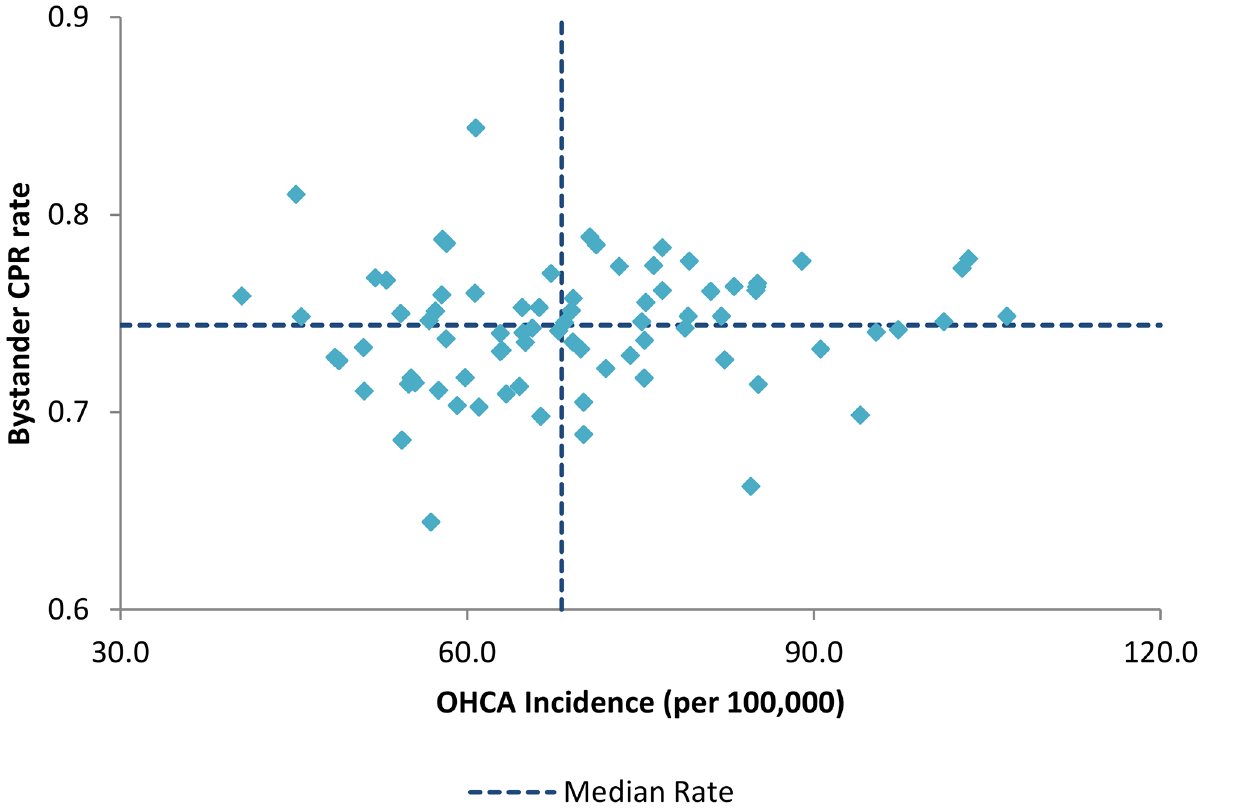
Fig 5. Incidence of OHCA and the prevalence of Bystander CPR 2011 – 2013 by Victorian Local Government